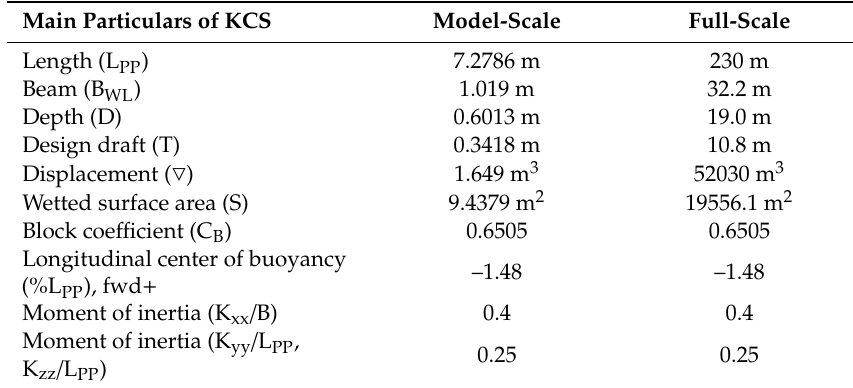
Table 1. Main parameters of ship geometry.